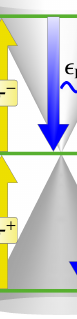
Figure 12: Phonon-induced carrier relaxation. Sketch of the ener- getically lowest Landau levels with the Dirac cone for vanishing magnetic fields in the background. The yellow arrows represent the linearly polarized optical excitation, which effectively pumps carri- ers from LL −1 to LL +1 in an undoped system. The phonon-induced inter-Landau level transitions, which are accompanied by the emis- sion of phonons with the energy ϵ Γ TO , are indicated by the blue